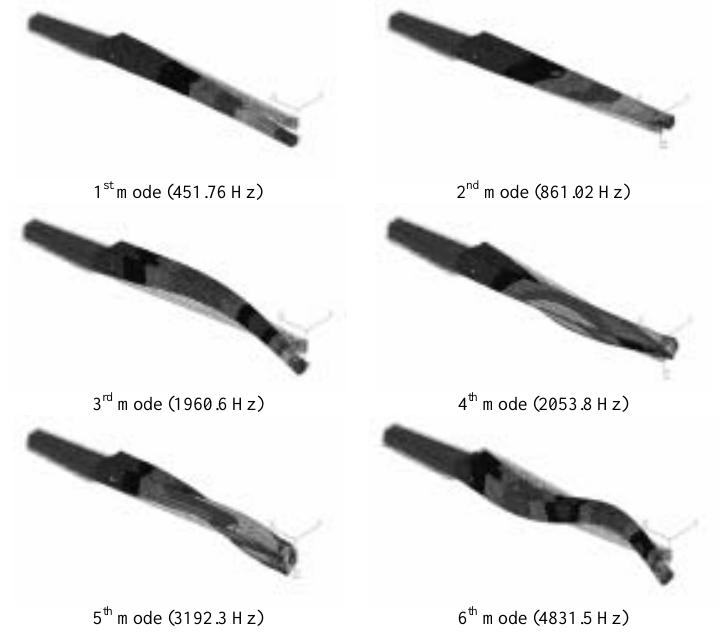
Fig. 21. The first six mode shapes of the bond arm.